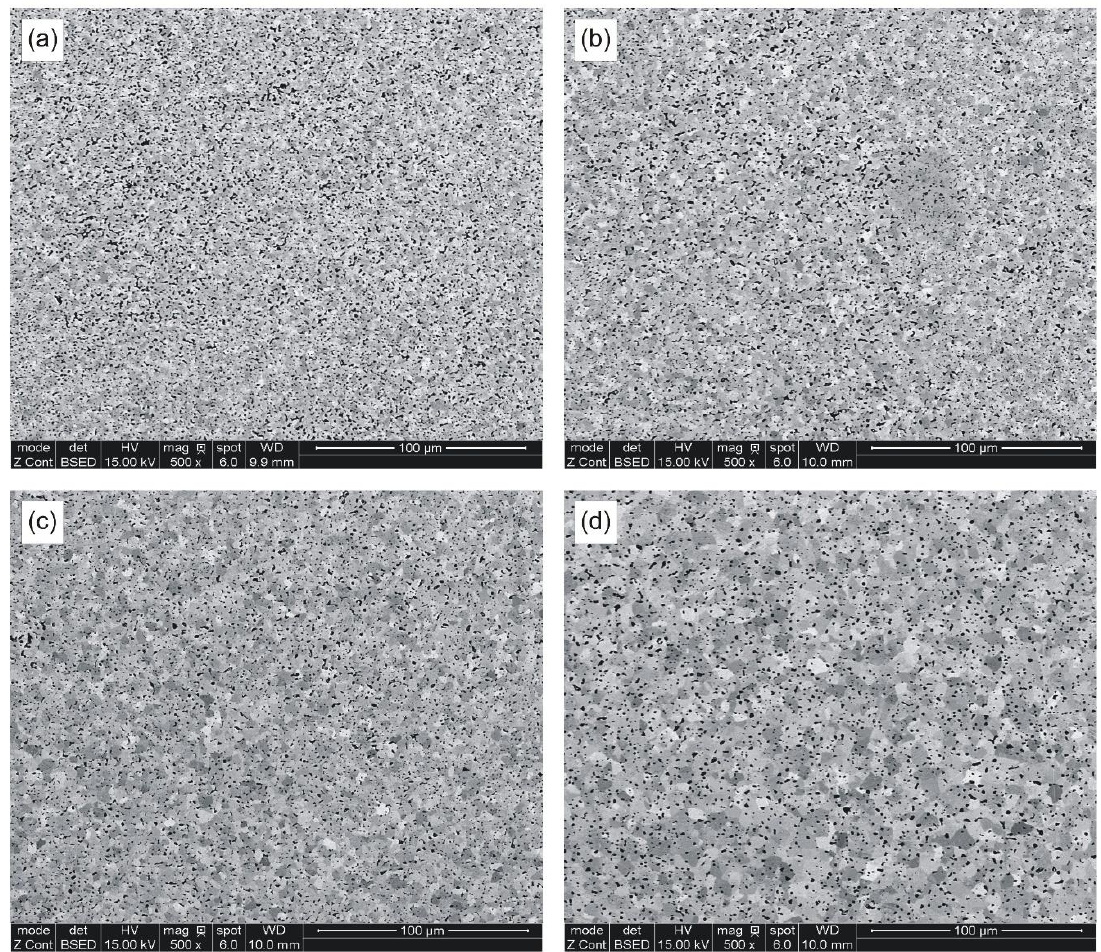
Figure 6. SEM micrographs of samples sintered at: ( a ) 850 °C; ( b ) 874 °C; ( c ) 898 °C; and ( d ) 924 °C.